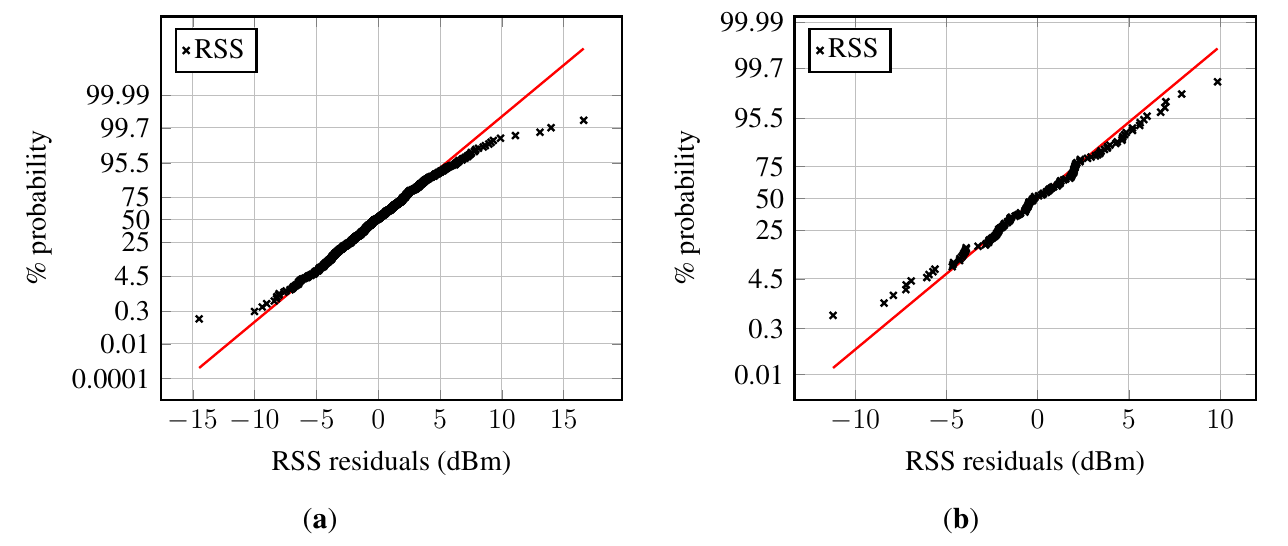
Figure 9. Norm probability plot of the model residuals from Gaussian process regression models of two different access points: ( a ) An access point with many fingerprints; ( b ) an access point with few